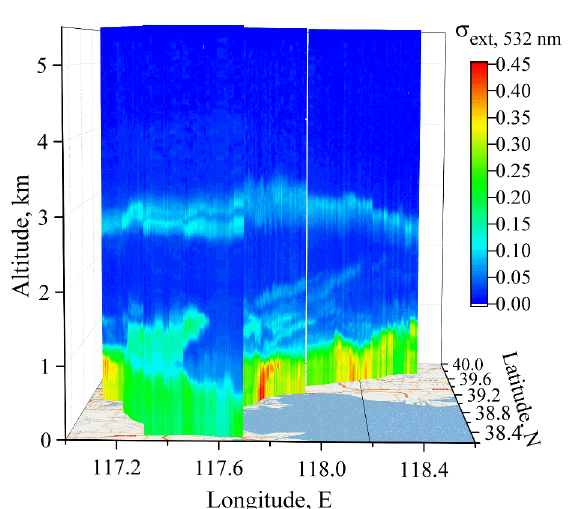
Figure 4. 3-D representation of the variability of lidar- derived extinction coefficients at 532 nm along the mobile transect from Tianjin to Tangshan The profiles of aerosol mass concentration were estimated from the extinction coefficients profiles and using microphysical and optical properties of two defined aerosol models: an urban/industrial aerosol model in the PBL and a desert dust model for the elevated layer in the 2.2 – 3.5 km altitude range. The extinction profiles below 200 m are constrained by in situ extinction measurements at ground level.